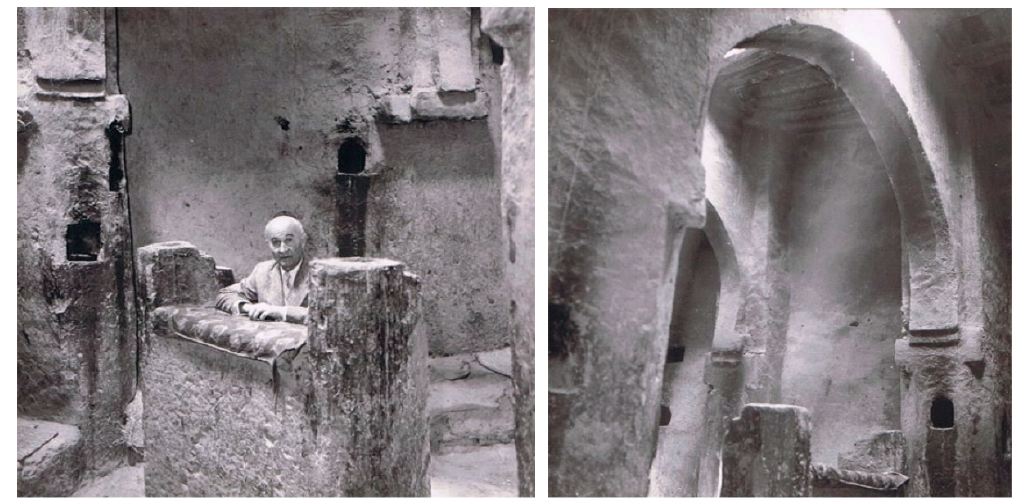
Figure 2. Synagogue of Amezrou, 1950 (Schulmann, Z é d é ), https://www.moroccan-judaism.org/phototheque. Paul Dahan